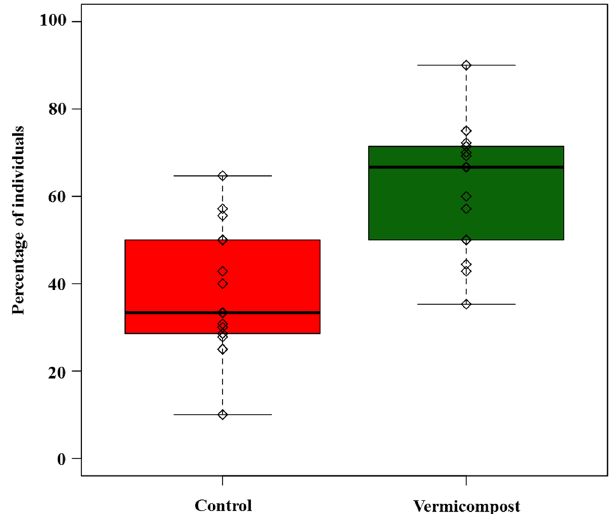
Figure 2. Percentage of Chrysoperla carnea moving towards plants of Nerium oleander grown in a potting soil initially containing a sterile (Control)/non sterile (Vermicompost) inoculum and after Aphis nerii attack.